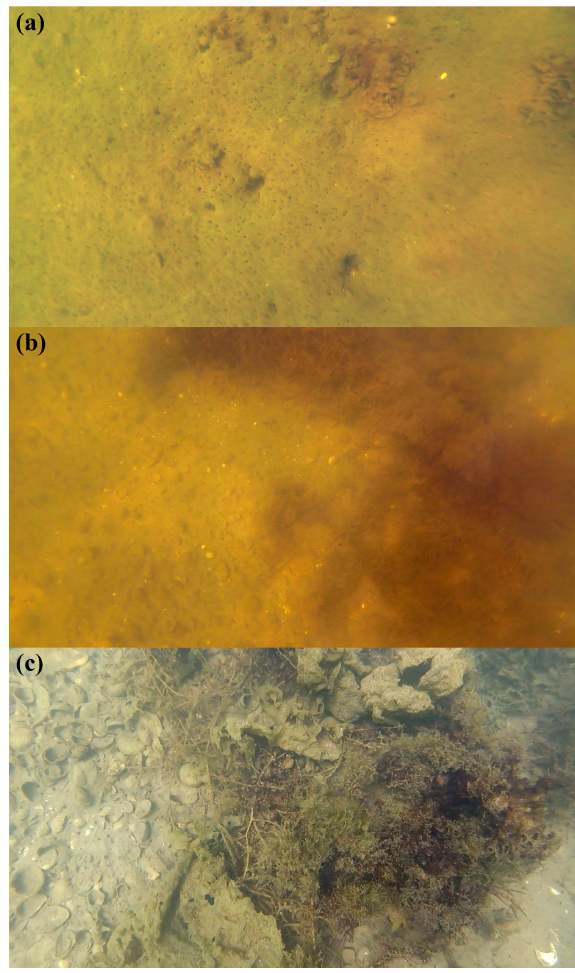
Figure 15. Example of bottom-cover classes in the